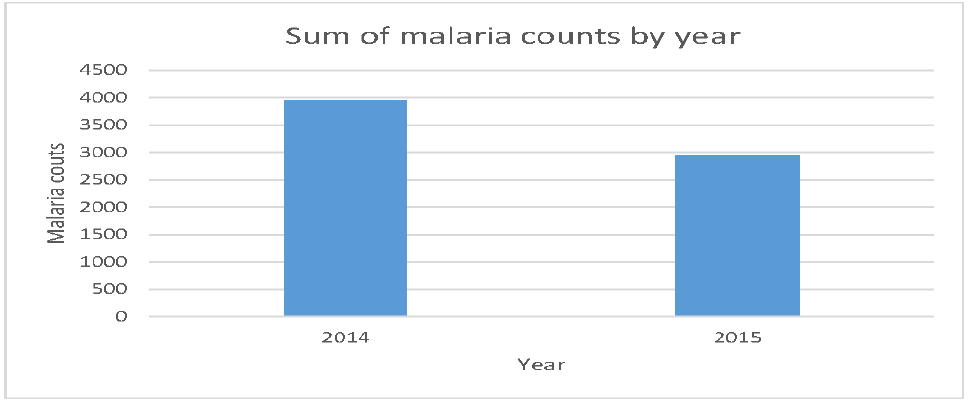
Figure 2. The distribution of malaria incidence in 2014 and 2015.